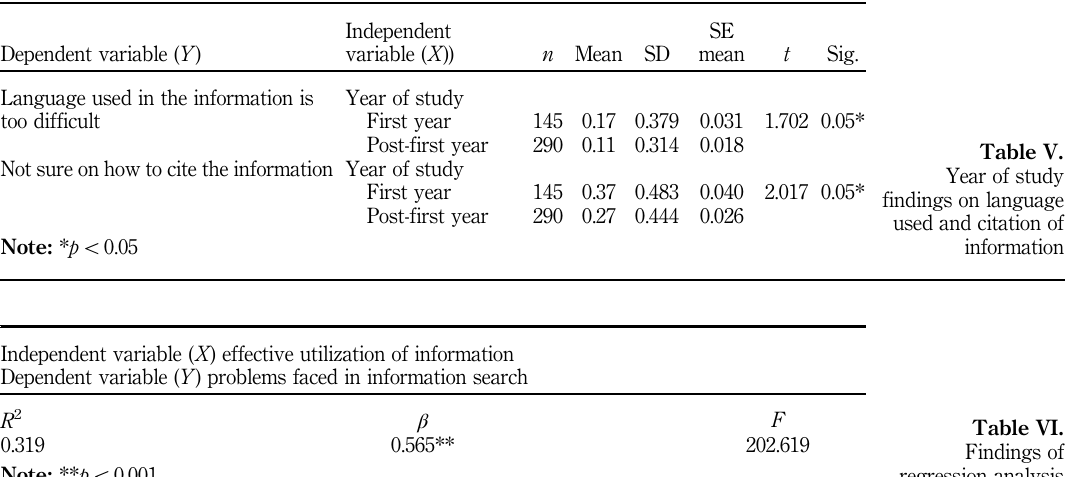
Table VI. Findings of regression